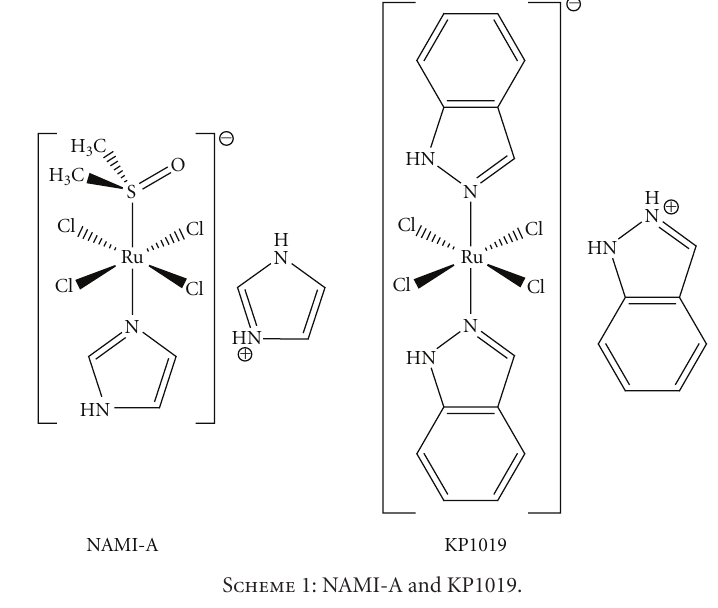
Scheme 1: NAMI-A and KP1019.